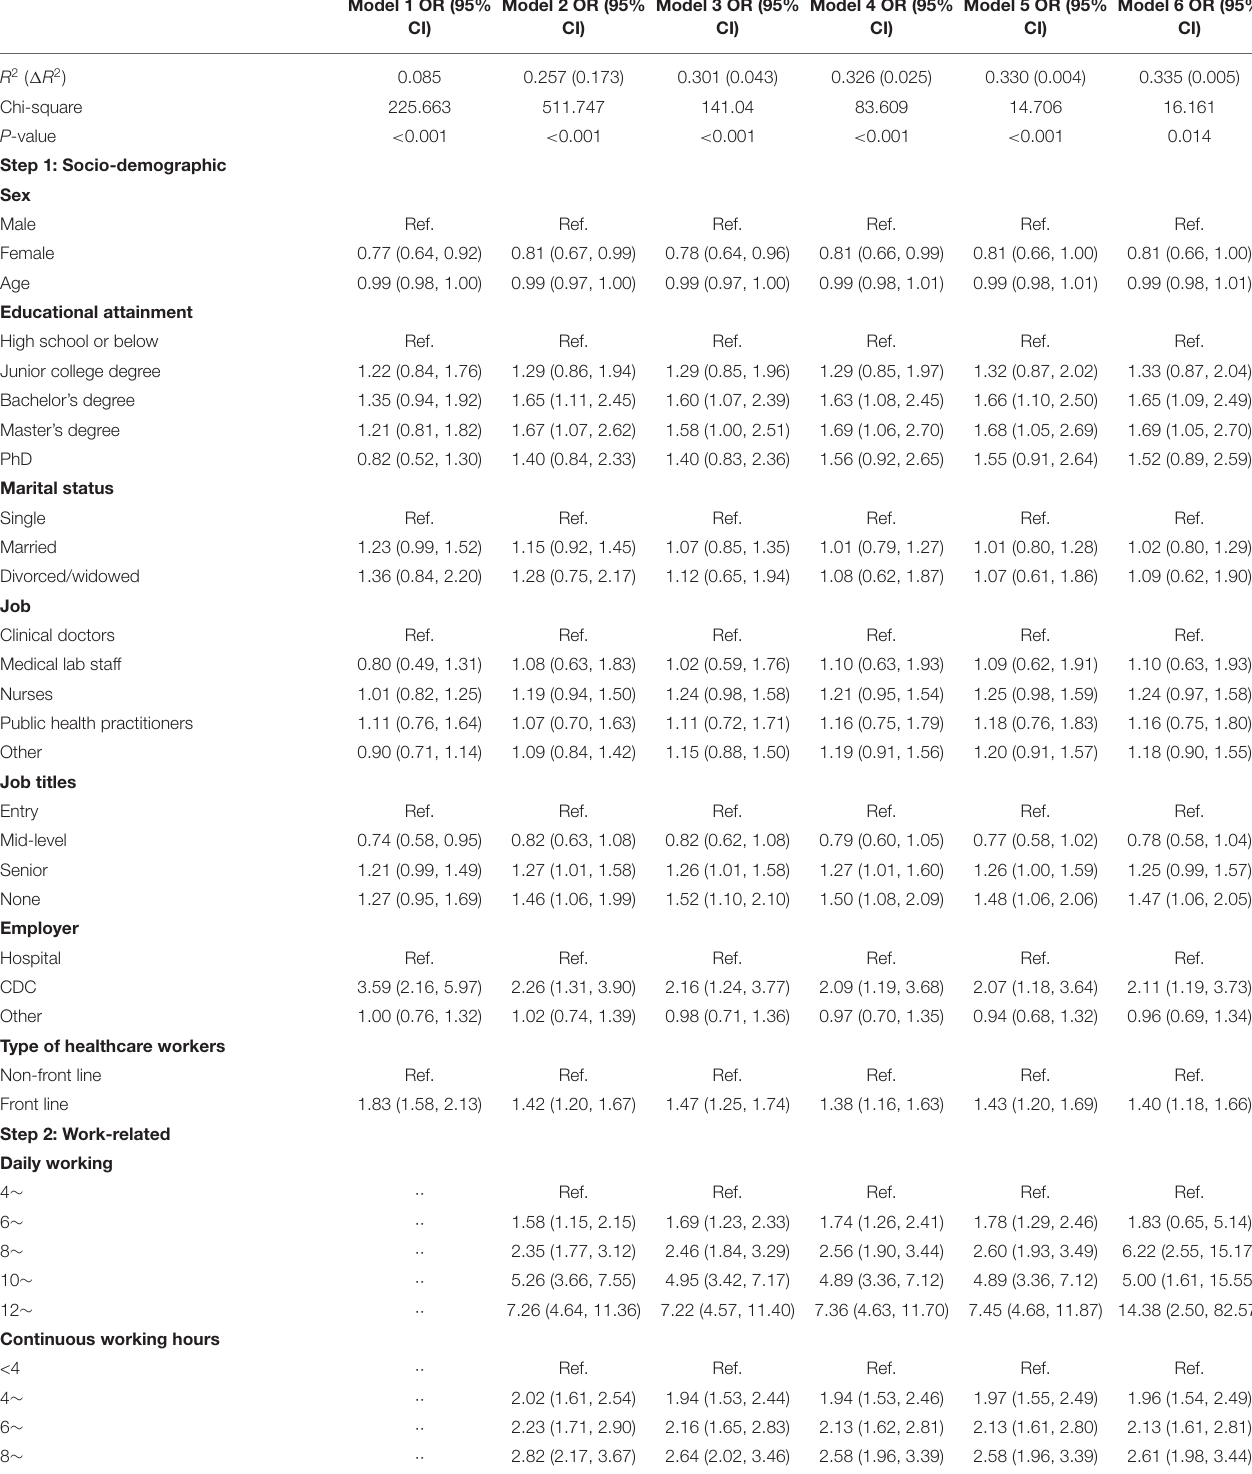
TABLE 3 | Logistic regression of factors correlated with fatigue among healthcare workers during the COVID-19